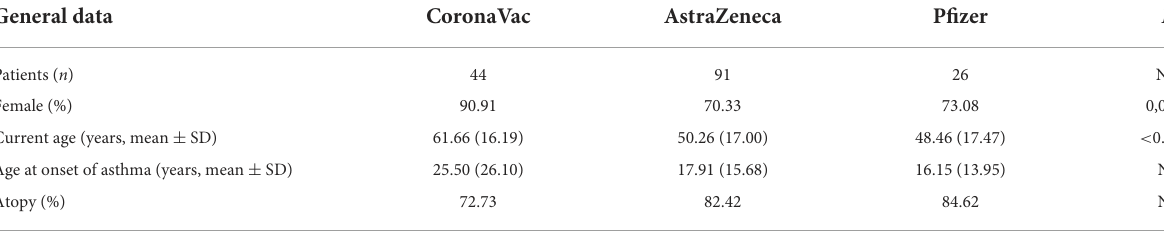
TABLE 4 Characteristics of asthmatic patients according to the vaccine ( n =